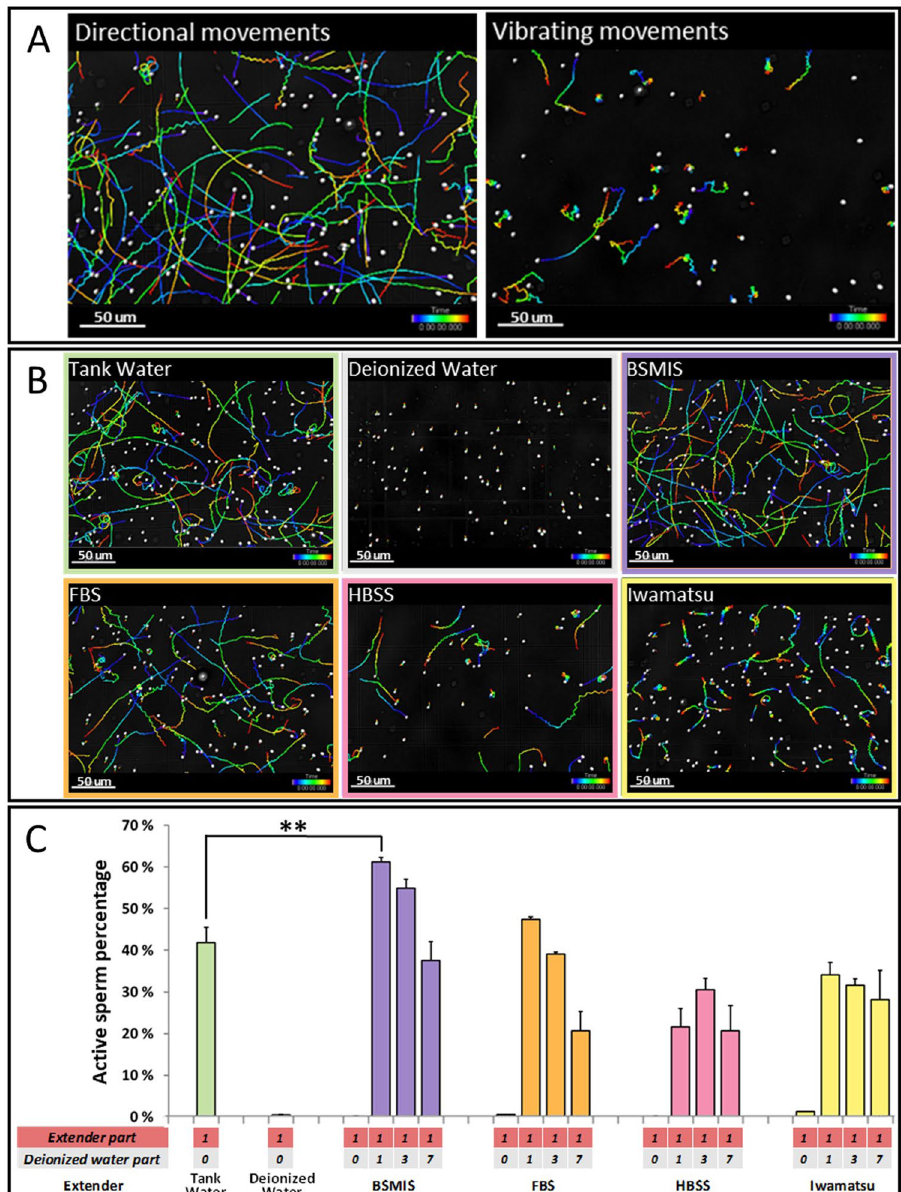
Figure 1. Fresh sperm activation in different buffers. ( A ) Motility tracing of different types of sperm movement that occur after activation, resulting in proper directional movements (left) or erratic inefficient vibrating movements (right). ( B ) Representative images of sperm movement in samples activated by 1:1 dilution of the indicated buffers. (Images in A and B were exported from Imaris, version 8.1, https:// imaris. oxinst. com/). ( C ) Quantification of sperm activation in different buffers, calculated as the average number of active sperm divided by total sperm among biological replicates. Asterisks indicate solutions that are significantly more effective than tank water in activating sperm based on a two-way ANOVA post hoc Dunnett’s test. *p < 0.05, **p < 0.01, ***p < 0.001. N = 3 biological replicates for each